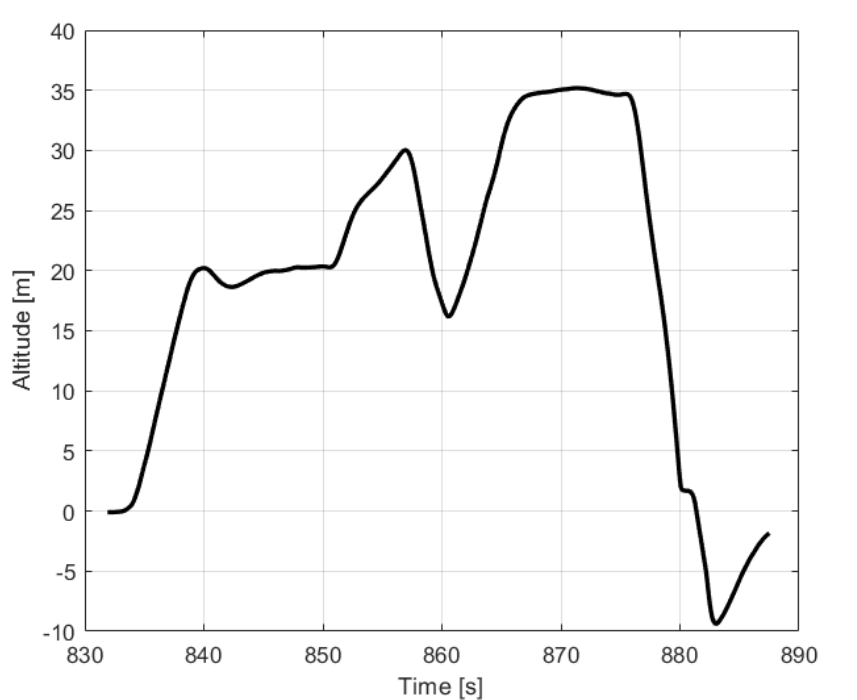
Figure 6. Altitude profile of VTOL UAV during crash